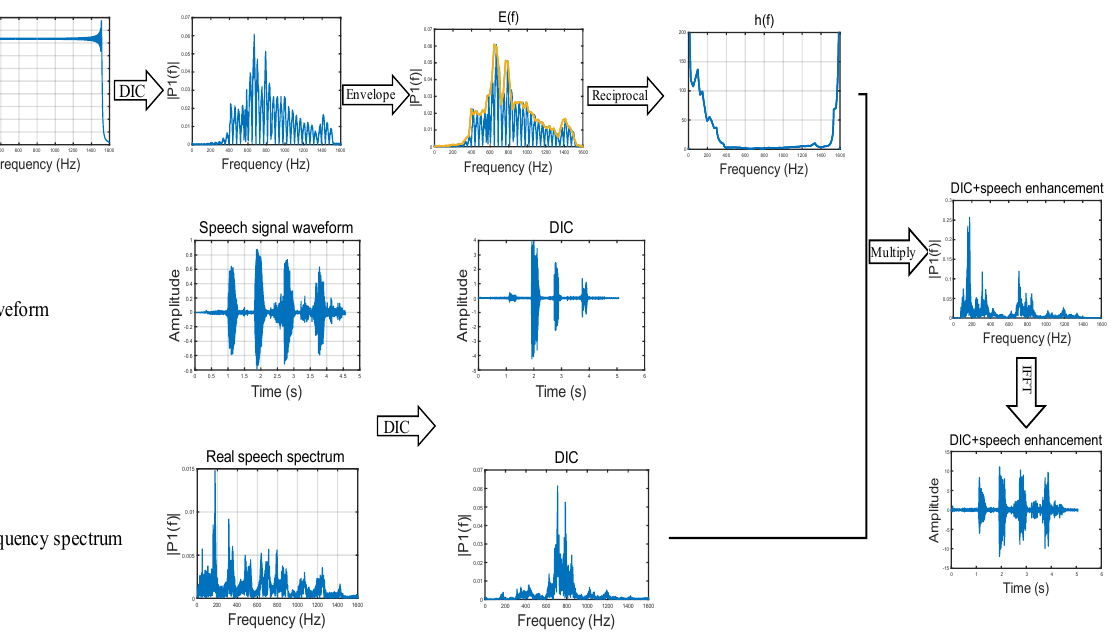
Figure 6. Speech enhancement algorithm.